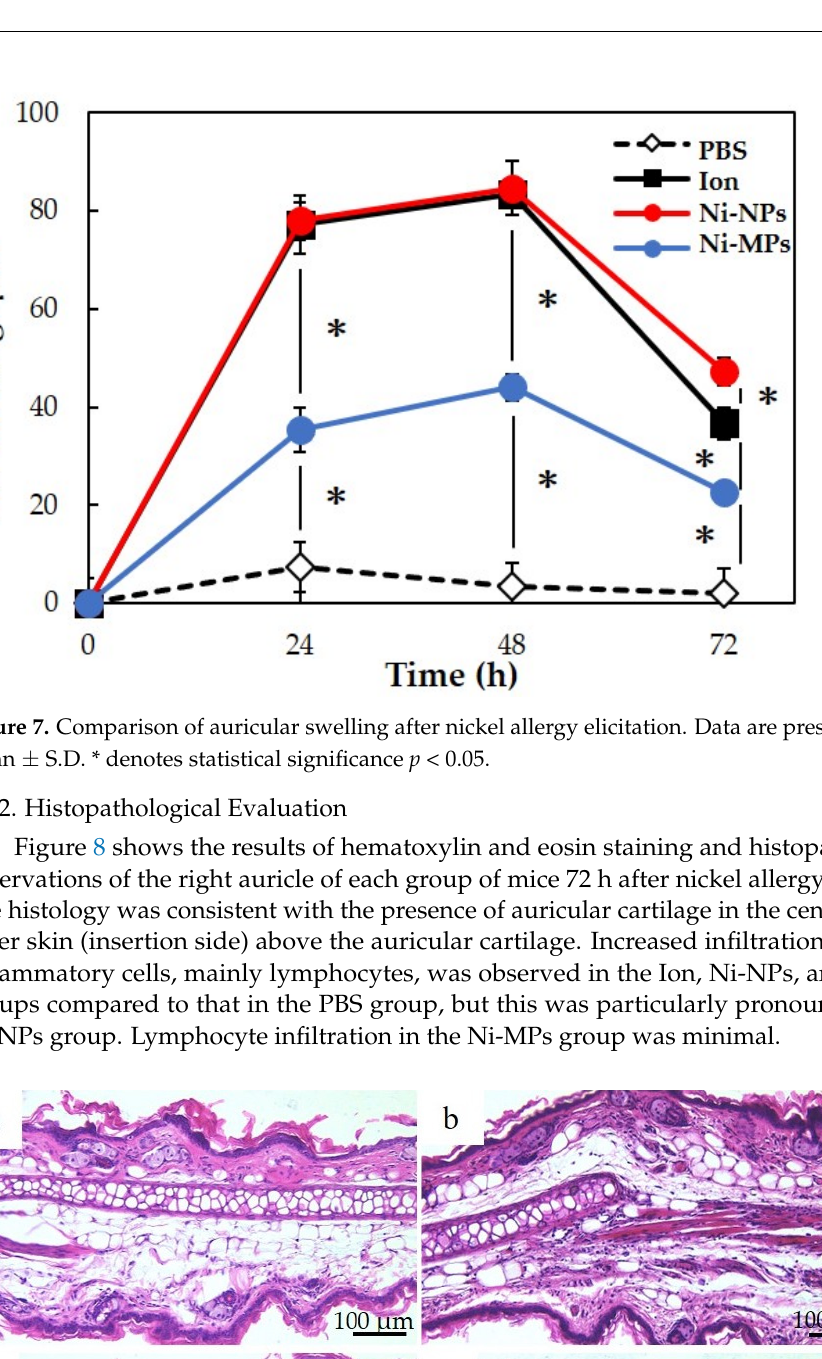
and fluid volume on the thickness were negligible. In the three groups (Ion, Ni-NPs, and